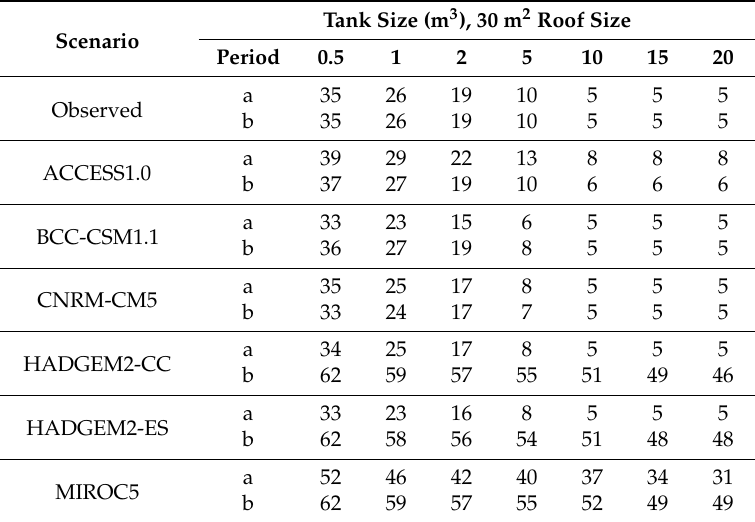
Table 6. Observed and projected water security (%) for MAM rain season.